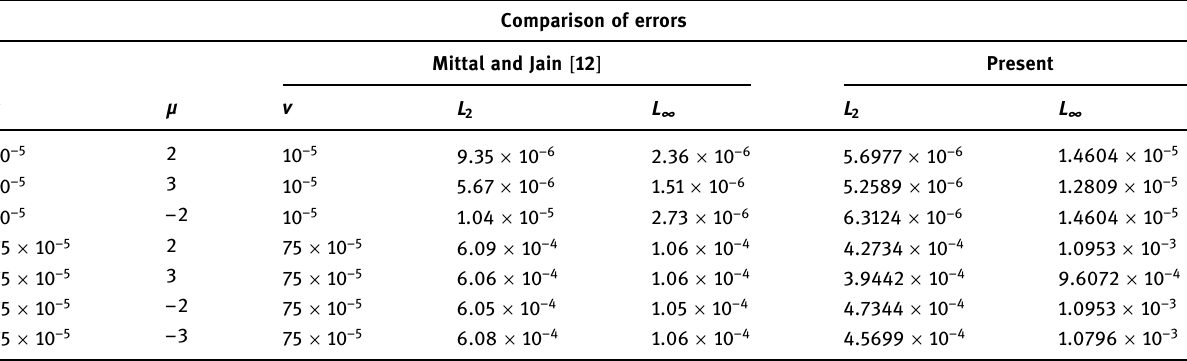
Comparison of errors Mittal and Jain [ 12